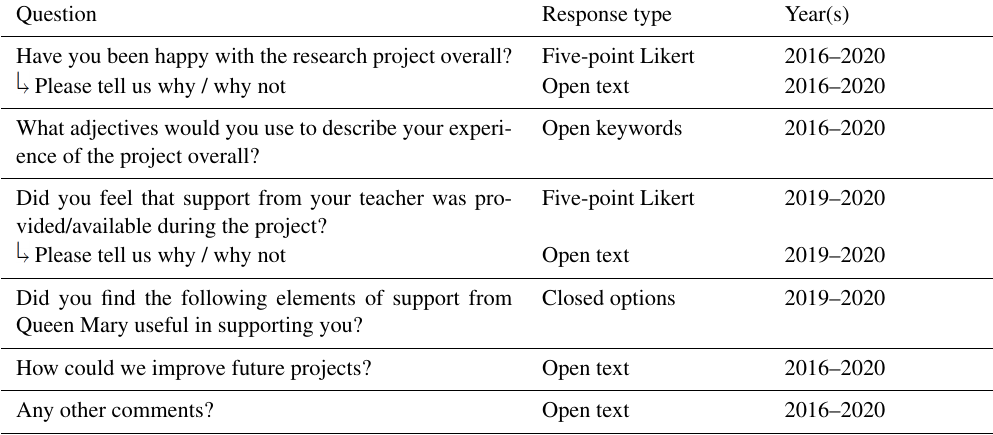
Table B1. The questions asked of students.